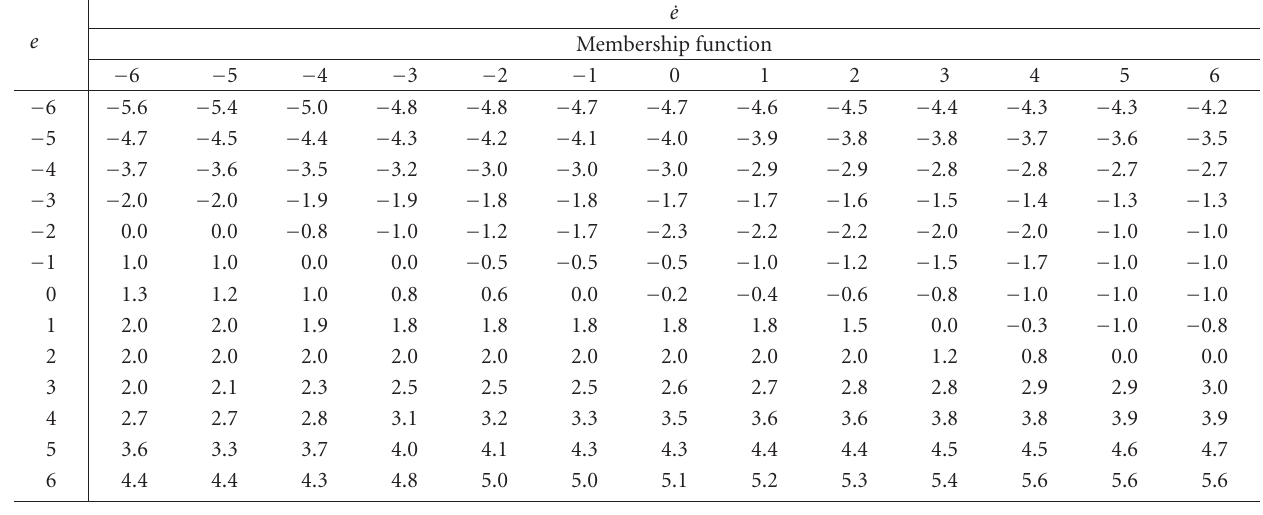
Table 1: Lookup table for the fuzzy controller.